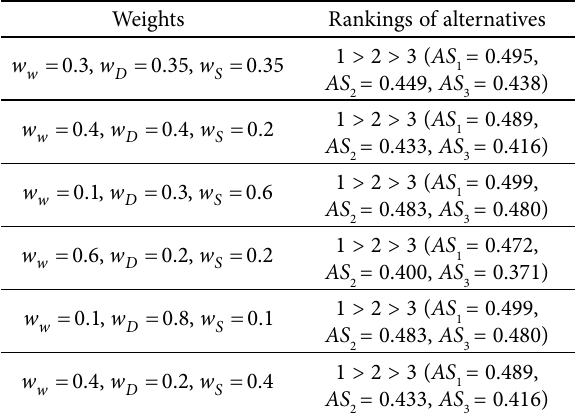
Table 10. Sensitivity analysis by changing criteria weights